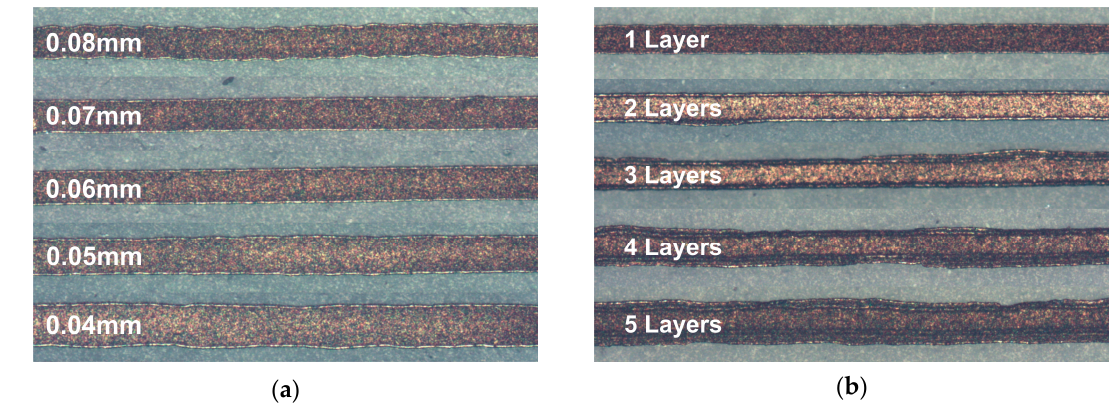
Figure 5. Optical micrograph images showing variation of line width of room-temperature printed lines on photo paper from a 50 µm nozzle by ( a ) increasing pitch of single pass print from 80 µm to 40 µm and ( b ) overprinting of layers up to five times at pitch 65 µm.